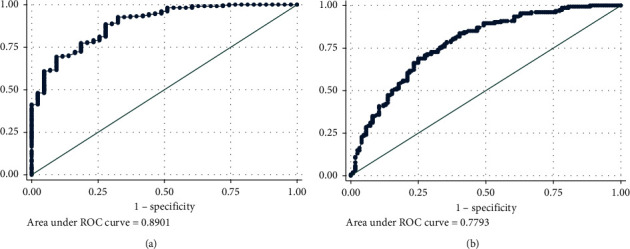
The area under the ROC curve of combination of FeNO and ACT in detecting (a) GINA-defined uncontrolled asthma and (b) GINA-defined well-controlled asthma.